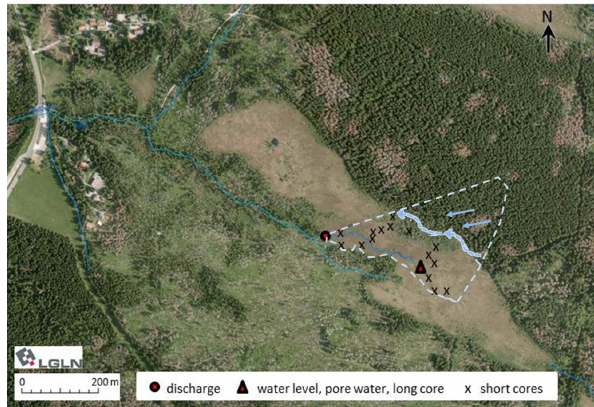
Figure 1. Location of the study area in the Harz Mountains, north- western Germany, with catchment boundaries indicated by the dashed light-colored line. The circle denotes discharge monitor- ing site and the triangle marks location of pore water sampling, as well as water level monitoring and peat core retrieval. Crosses mark the location of short cores for inventory calculations. Map source: Lower Saxony Ministry for Environment, Energy and Climate Pro-